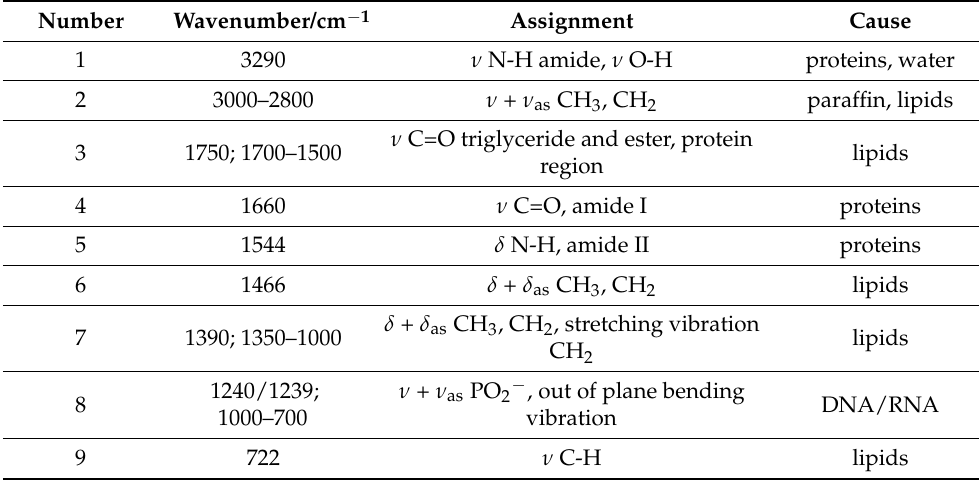
Table 1. Spectral band assignment for the salivary gland tissue, Warthin tumor, pleomorphic adenoma, formalin pure and paraffin pure FTIR average spectra. All assignments are mainly based on